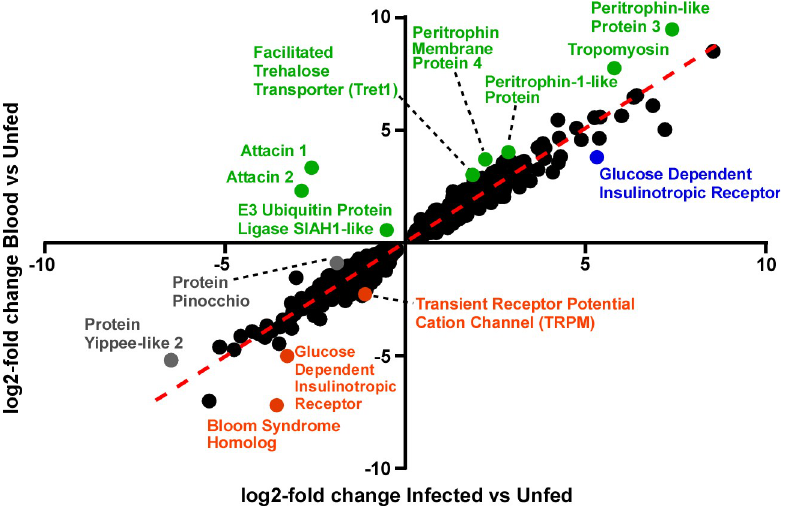
Fig 3. Infection-responsive transcripts identified by expression differentials in sterile blood-fed and infected fleas compared to unfed fleas. Scatter plot of 2-fold change values for all transcripts (n = 3501) that were significantly altered in both the sterile blood-fed vs unfed (x-axis) and unfed vs. infected blood-fed (y-axis) statistical comparisons (Fig 1A and Table 1). The 14 annotated outlier transcripts ( � 2-fold change differential) that were more upregulated in infected fleas (green symbols), more downregulated in infected fleas (orange symbols), more upregulated in sterile blood fed fleas (blue symbol), or more downregulated in sterile blood fed fleas (grey symbols) are labeled. These transcripts are listed in Table